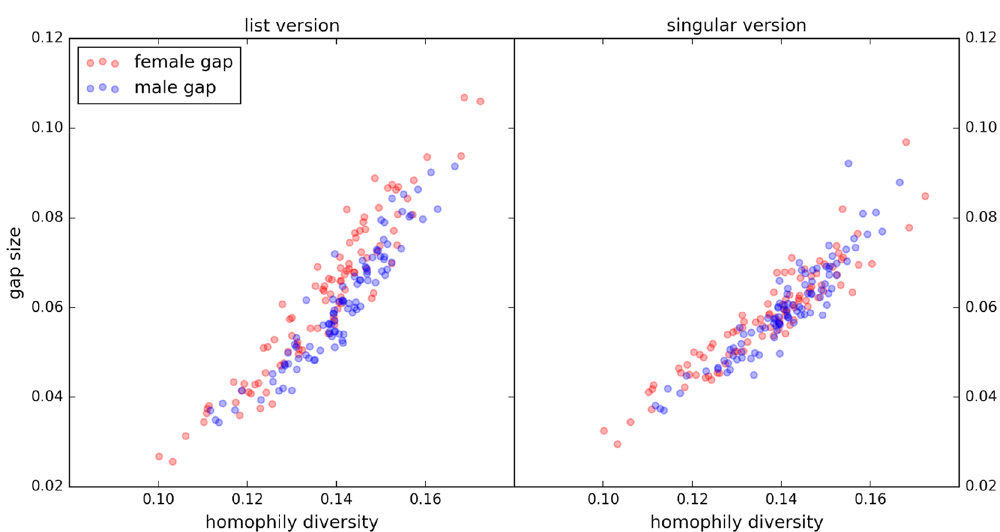
Figure 3. For each school whose gap was computed in Fig. 2, we compute the standard deviation of the first- order homophily values for each type, and plot these against the gap for both the list and singular versions. Consistent with the notion that homophily diversity drives these gap phenomena, we find close alignment between the standard deviation in first-order homophily values and the gap size, with a correlation of